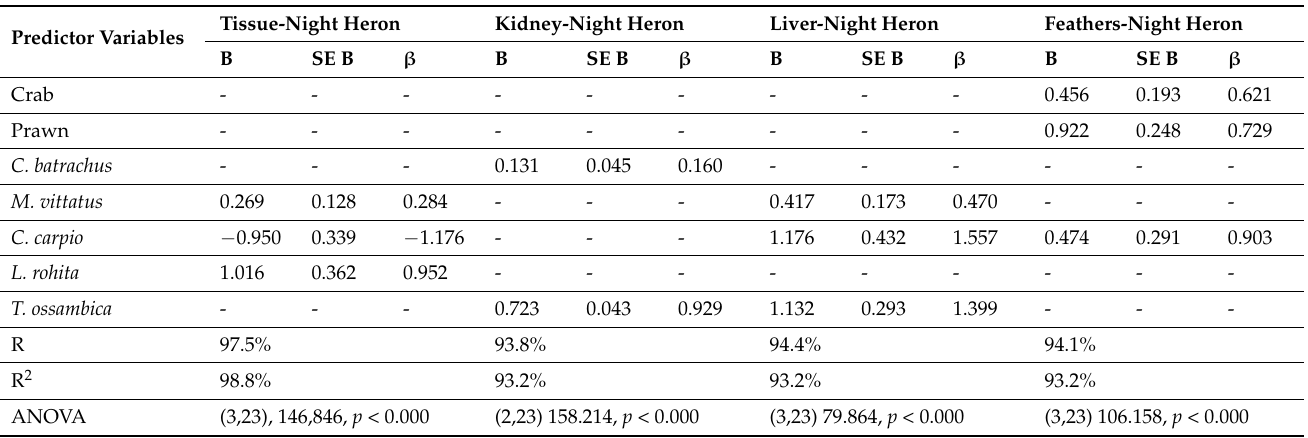
Table 7. The simple regression model explains the influence of various prey species on the accumula- tion of metals in tissues, kidneys, liver and feathers of black-crowned night heron, Veeranam Lake, Tamil Nadu,